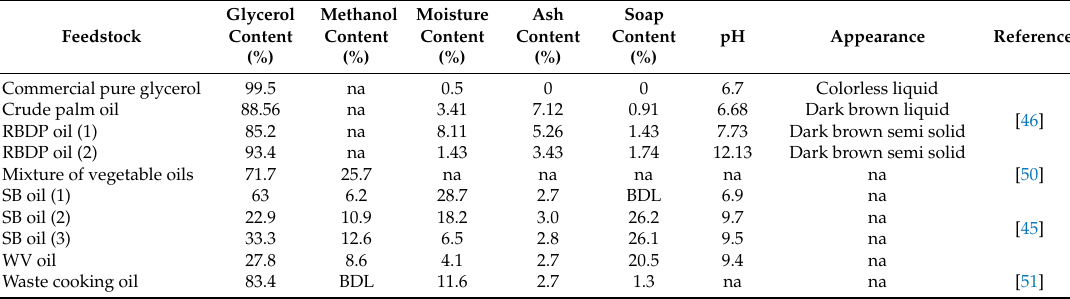
Table 5. Quality of various crude glycerol from biodiesel plants by different